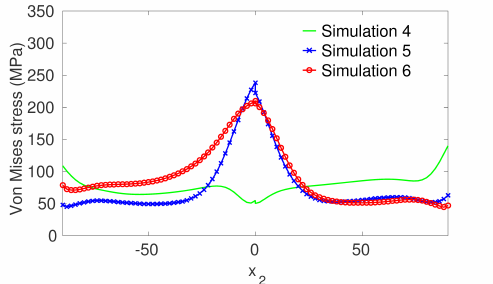
Figure 9. Profiles of Von Mises stress along x 2 through point A ( − 40,0,0) obtained by FE simulations 4, 5 and